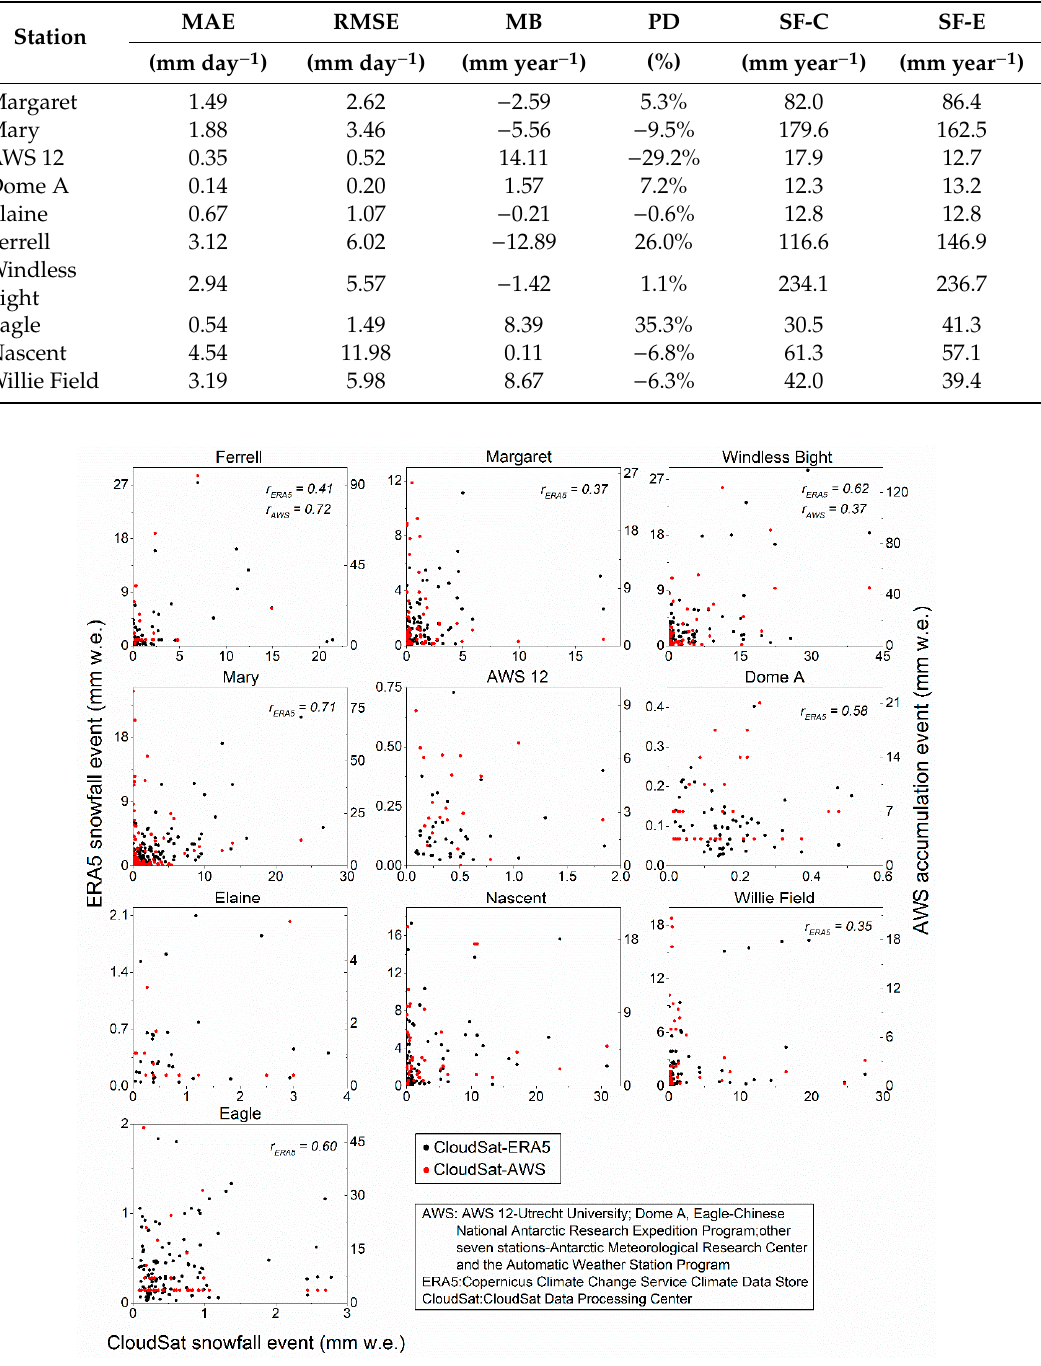
Figure 4. Di ff erent event sizes of all coincident events (mm w. e.). The right-hand axes show ERA5 snowfall events, the left-hand axes show AWS accumulation events and the x axes show CloudSat snowfall events. The r values are shown for correlations between CloudSat and ERA5 snowfall events and AWS positive accumulation events at the 99% significance